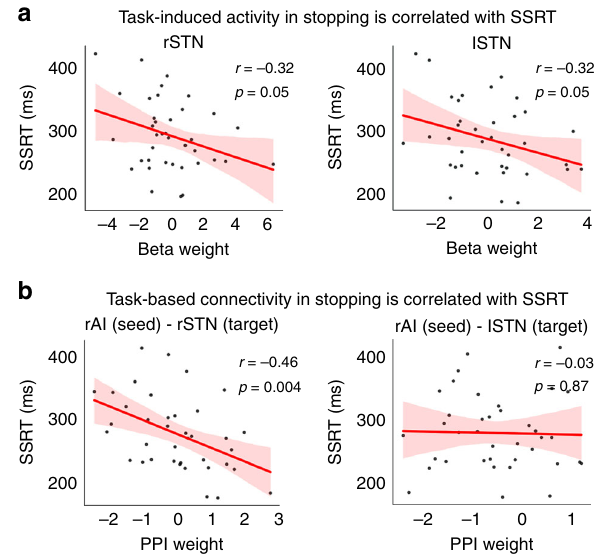
Fig. 7 STN activity and connectivity predict stopping in children. a Activation in the STN during stopping was negatively correlated with SSRT in children. b Effective connectivity between the rAI (seed) and rSTN (target) was negatively correlated with SSRT in children. No such relation was observed in the left hemisphere. Source data are provided as a Source Data fi le Table 3 Linear regression shows that rSTN activation